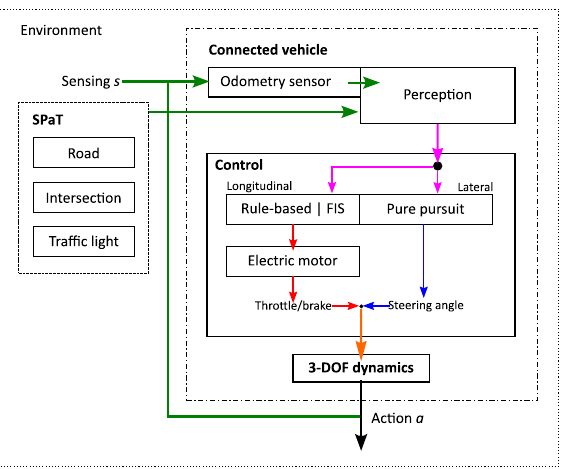
Figure 1. AV navigation block diagram. Sensor and SPaT data is represented by a green arrow, pro- cessed perception information in pink, longitudinal control in red, lateral control in blue, navigation inputs in orange and actions in